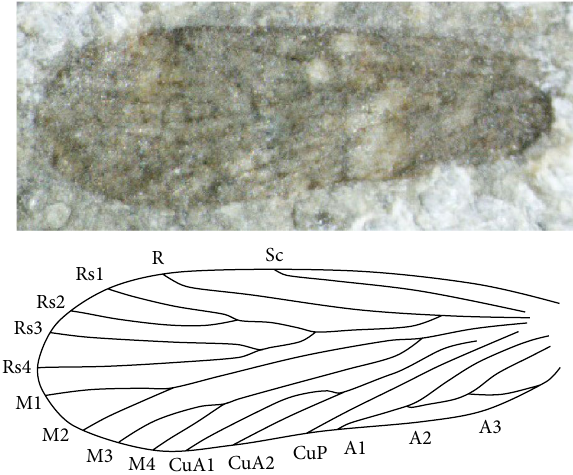
Figure 3: Example of English Necrotaulius parvulus (Geinitz, 1884), NHMUK I.15014 from Dumbleton pit, Gloucestershire (previous holotype of Necrotauliuspygmaeus Tillyard, 1933). Scale bar = 1 mm.